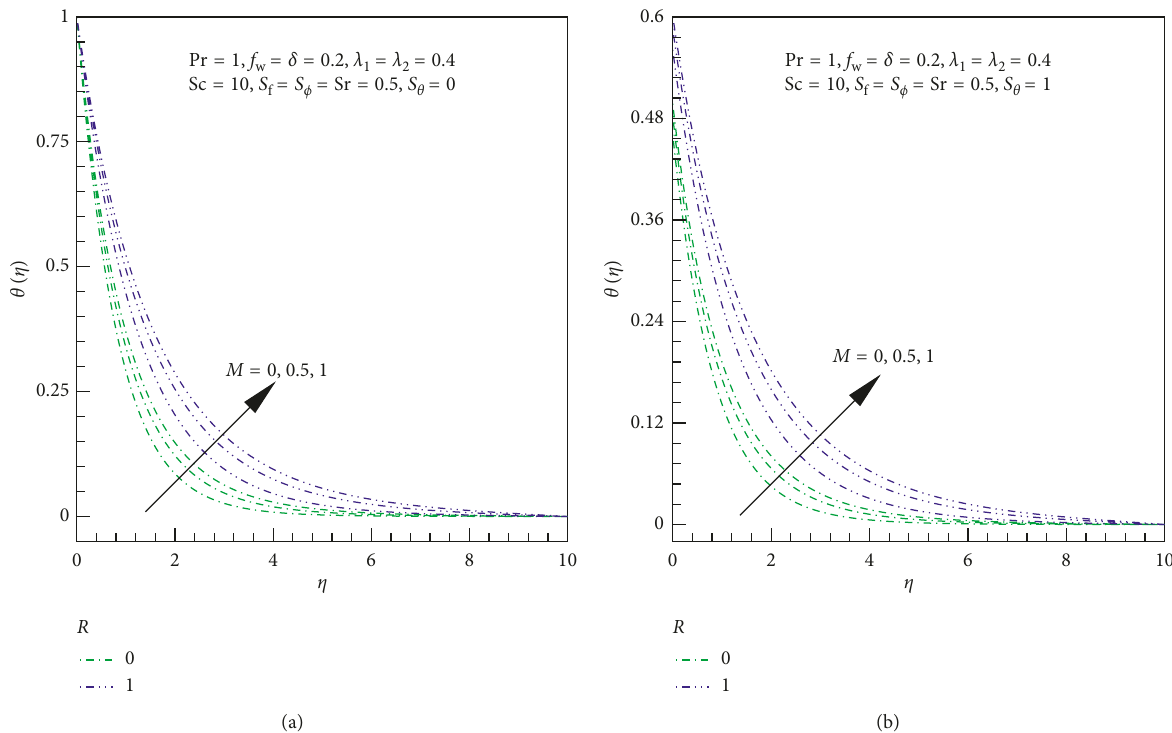
Figure 5: Effects of M and R on dimensionless temperature. (a) No thermal slip. (b) With thermal